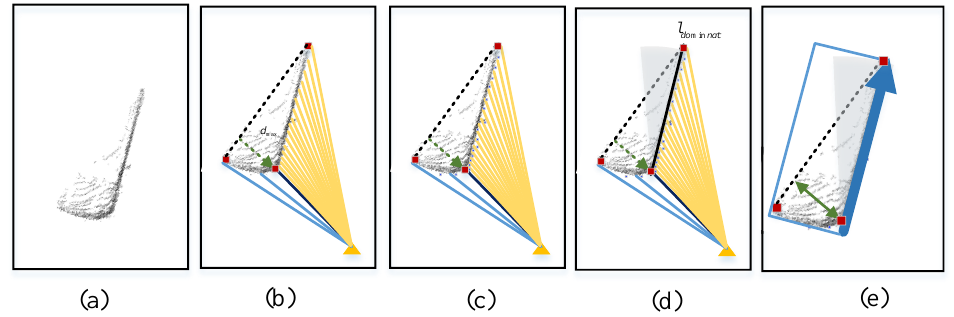
Figure 4. Illustration of the process for HL. ( a ) denotes a raw point cloud cluster, ( b ) shows the points segmentation, ( c ) displays the length-aware contours extraction in each segment, ( d ) exploits optimal contours extraction, ( e ) shows orientation fitting and position